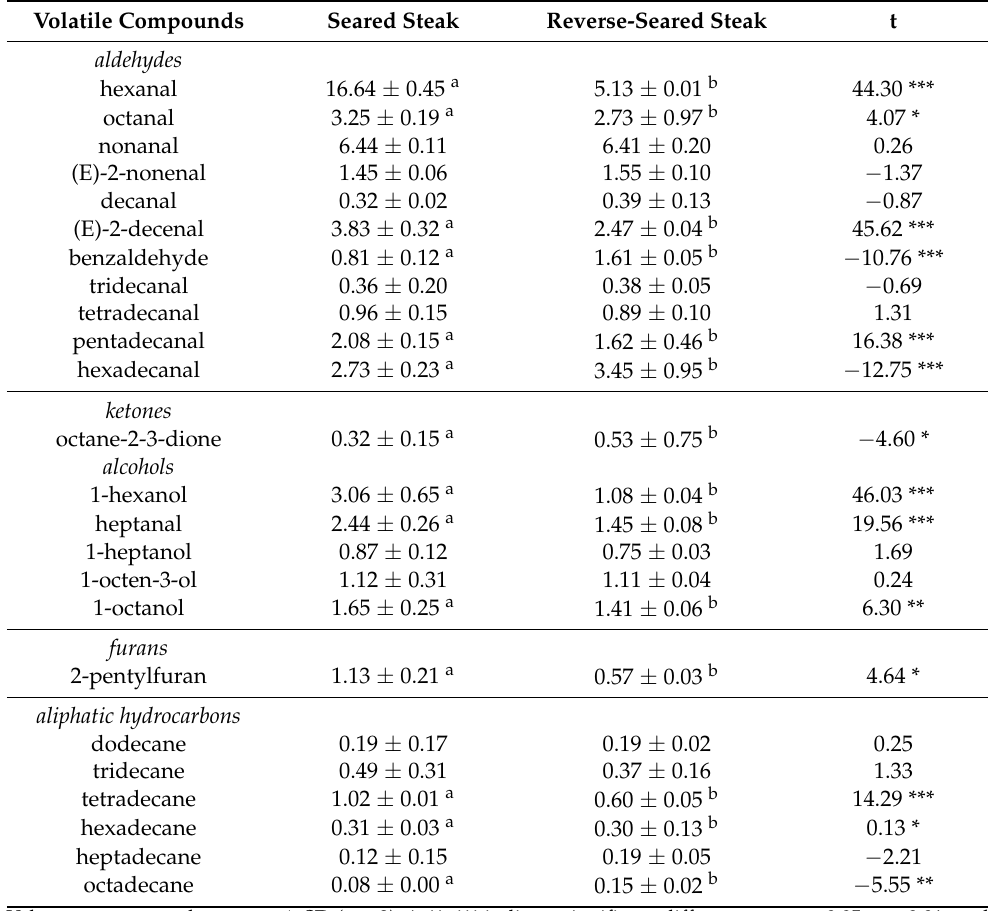
Table 4. Volatile compounds (%) of seared and reverse-seared